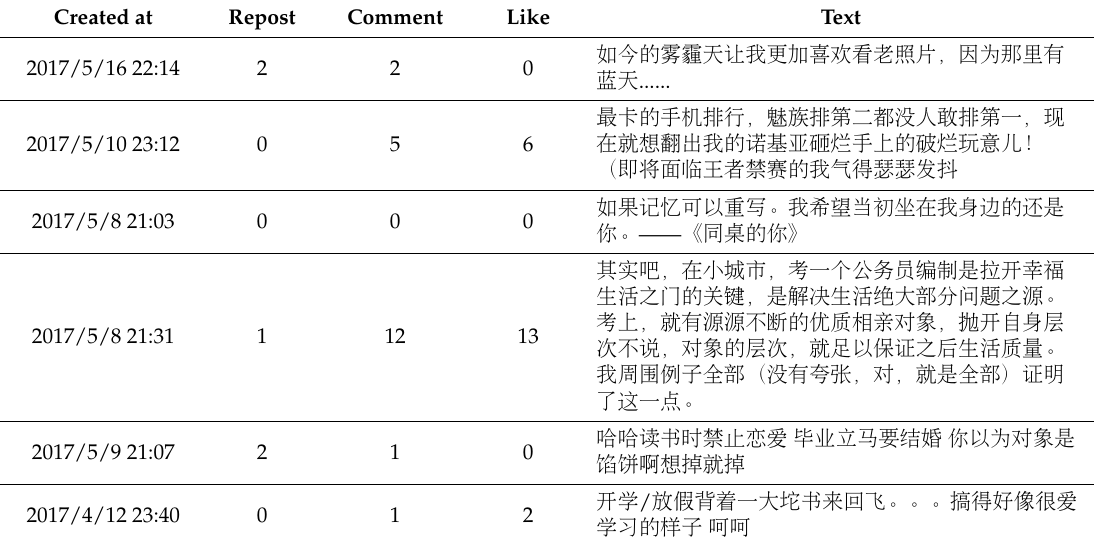
Table 2. An example of a dataset extracted from Sina Weibo. Created